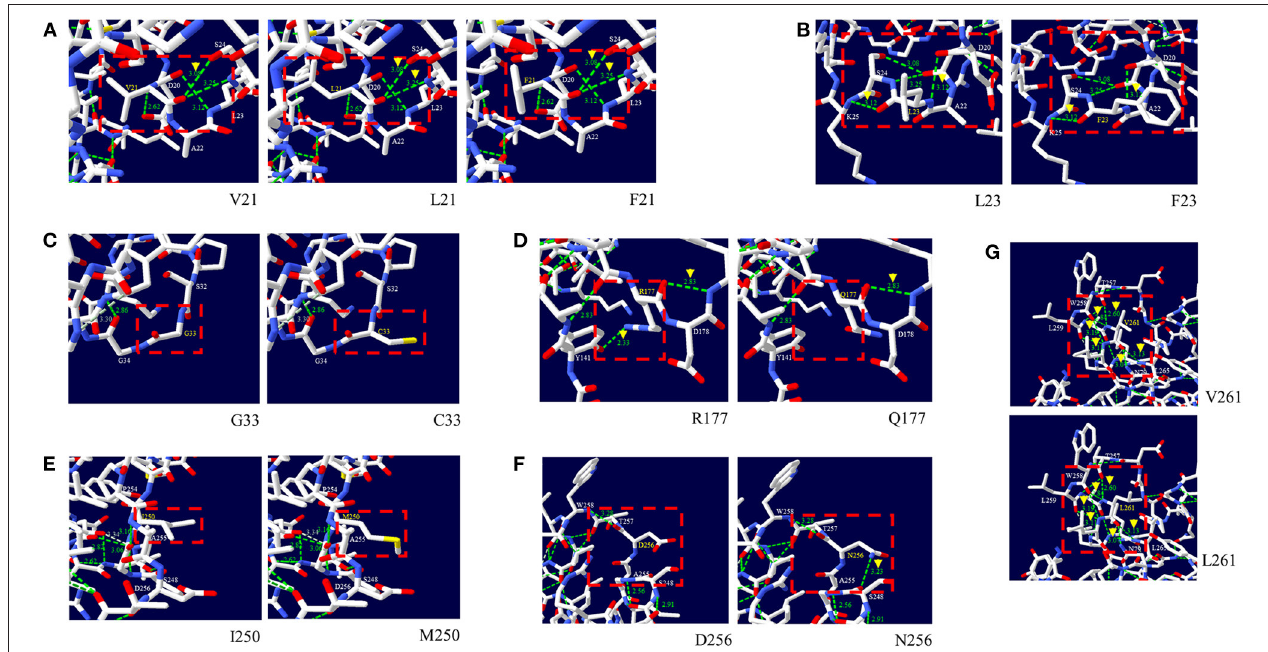
FIGURE 2 | Prediction of the tertiary structure and hydrogen bonds of the pheasant prion protein (PrP) according to the alleles of the non-synonymous SNPs of the pheasant PRNP gene. (A) 3D structure of pheasant PrP with the V21, L21, and F21 alleles. (B) 3D structure of the pheasant PrP with the L23 and F23 alleles. (C) 3D structure of the pheasant PrP with the G33 and C33 alleles. (D) 3D structure of the pheasant PrP with the R177 and Q177 alleles. (E) 3D structure of the pheasant PrP with the I250 and M250 alleles. (F) 3D structure of the pheasant PrP with the D256 and N256 alleles. (G) 3D structure of the pheasant PrP with the V261 and L261 alleles. The green dotted line indicates hydrogen bonds. The green numbers indicate the distance of the hydrogen bonds.